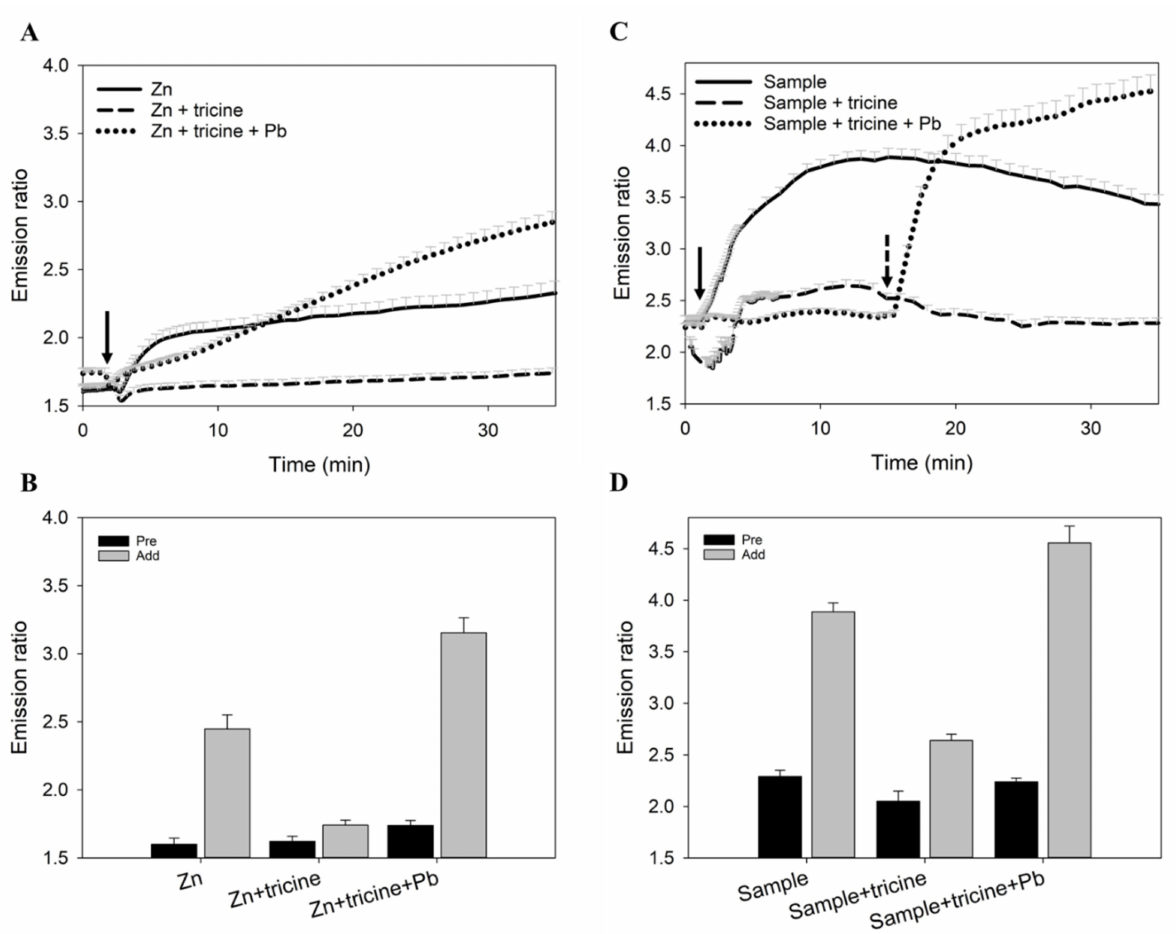
Figure 5. Removal of zinc with tricine enables practical Pb sensing by pMet-lead. ( A ) Time-lapse of the emission ratio (YFP/CFP) recorded by the Met-lead biosensing system. Double-distilled water (distillation-distillation H 2 O, ddH 2 O) from the laboratory was pre-mixed with 11 µ M zinc alone (Zn; solid line), 11 µ M zinc and 10 mM tricine (Zn + tricine; dashed line), or 11 µ M zinc, 10 mM tricine, and 10 µ M Pb (Zn + tricine + Pb; dotted line), and introduced at the time point indicated by the arrow. ( B ) Bar graphs of the averaged Y/C ratio values from Met-lead under the conditions in ( A ). ( C ) Samples of tap water from a laboratory faucet, without (sample; solid line) or with 10 mM of tricine added (sample + tricine; dashed line), and 10 µ M Pb (sample + tricine + Pb; dotted line) were placed in the Met-lead biosensing system at the time point indicated by the arrow. All experimental sample tests were with ionomycin (5 µ M). ( D ) Bar graphs of the averaged Y/C ratio values from Met-lead under the conditions in ( C